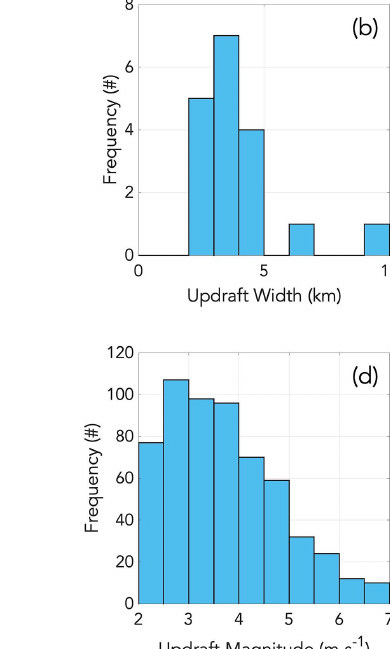
Fig. 5a, 66 % of V AIR values are greater than 3 m s − 1 in Fig. 5b, and 75 % of V AIR values are greater than 3 m s −